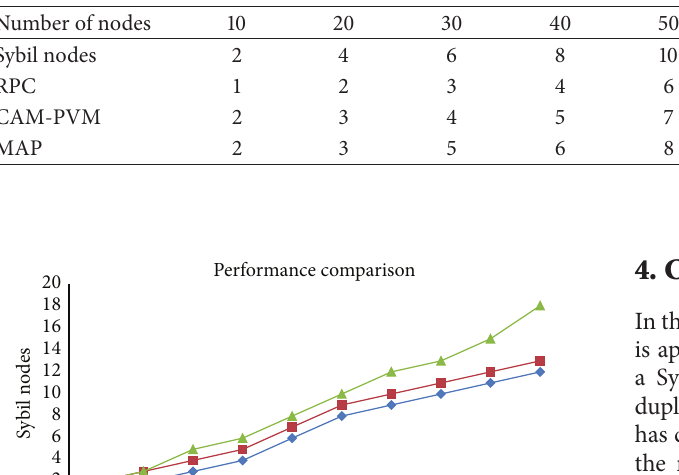
Table 4: Comparison of Sybil node with existing RPC method with CAM-PVM and MAP.